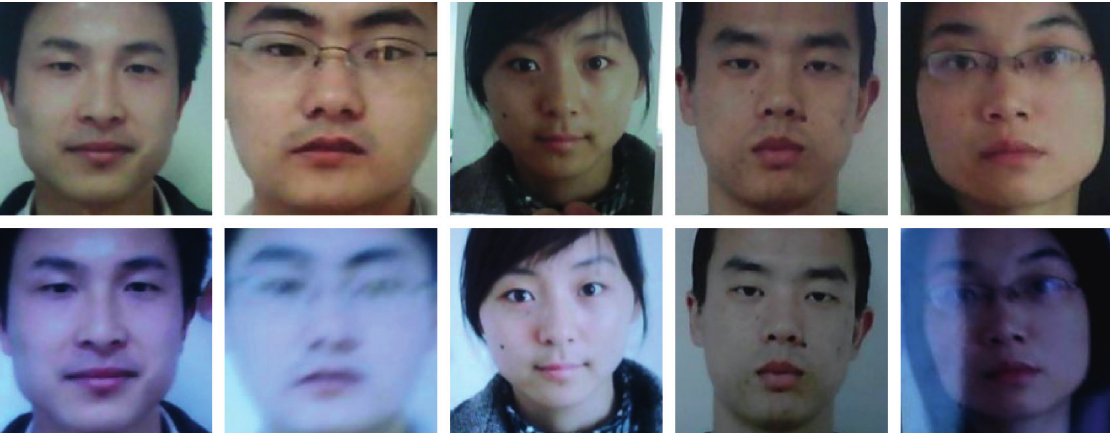
Figure 1: Face print and replay attack images. The face attacked has been collected many times, showing the difference between texture feature, light, image quality, and real face.